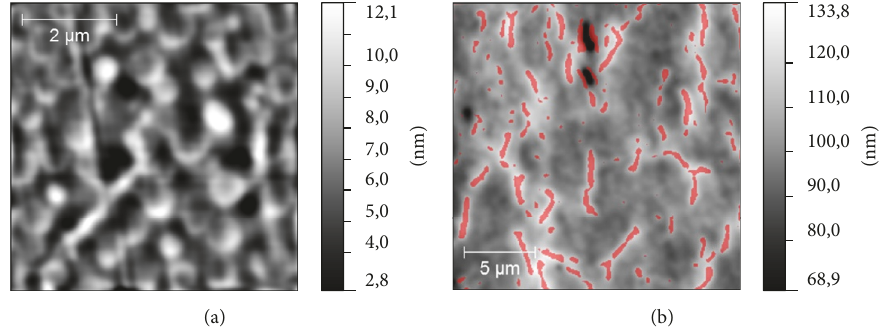
Figure 6: Topography of S3 sample on a different scale: (a) grain-like structure is shown; (b) dendrite-like structure is marked with a color mask and occupied the area from 10 to 15% on the